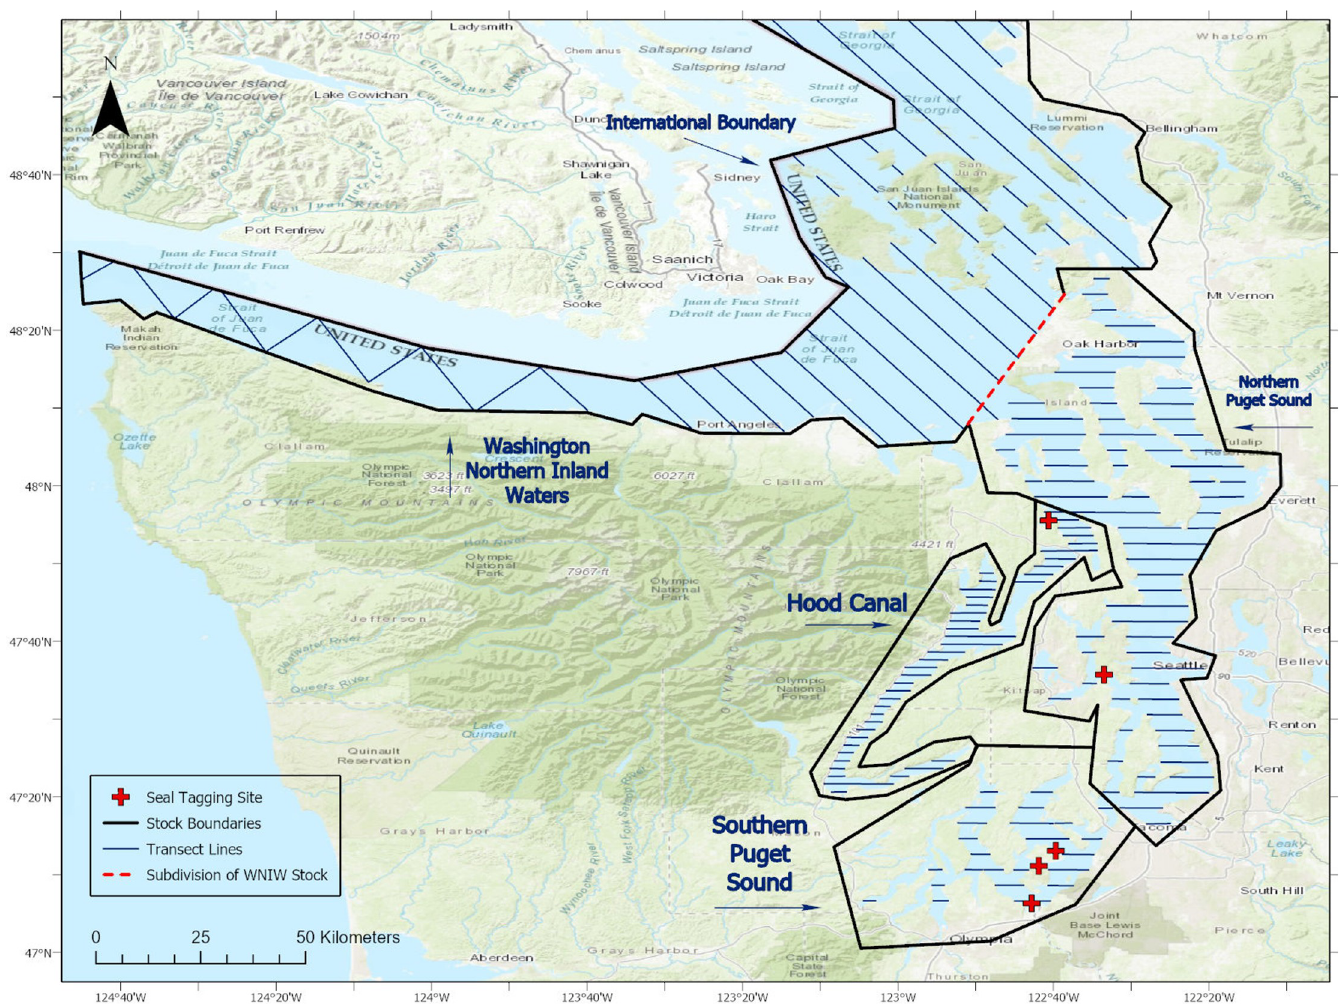
Fig 1. Map of the study area, showing the stock boundaries, planned transect lines, and locations of seal tagging areas. Map was created using ArcGIS 1 software by Esri. ArcGIS 1 and ArcMap ™ are the intellectual property of Esri and are used herein under license. Copyright © Esri. All rights